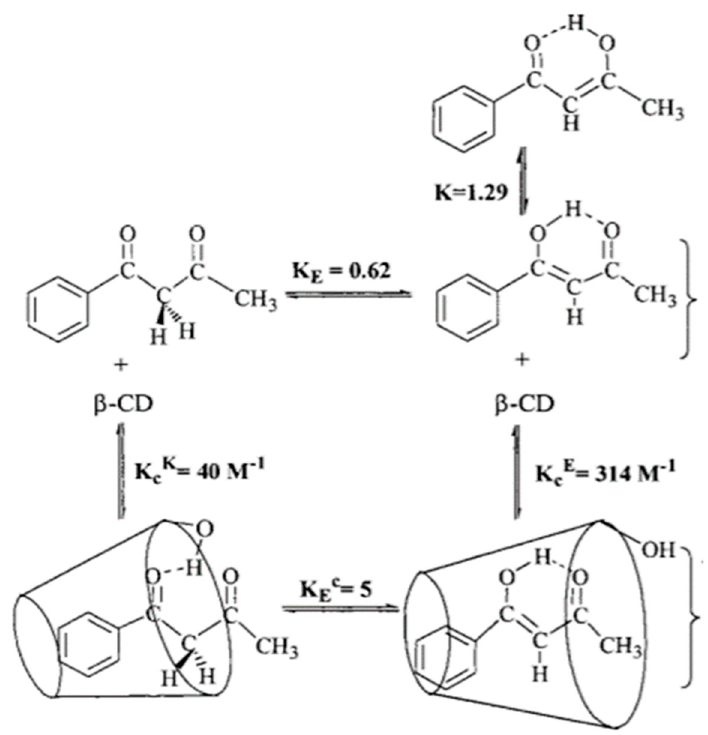
Figure 6. Benzoylacetone complexation with β -cyclodextrin. E refers to enol- and K to diketo-form. Taken from [35] with permission from the American Chemical Society.